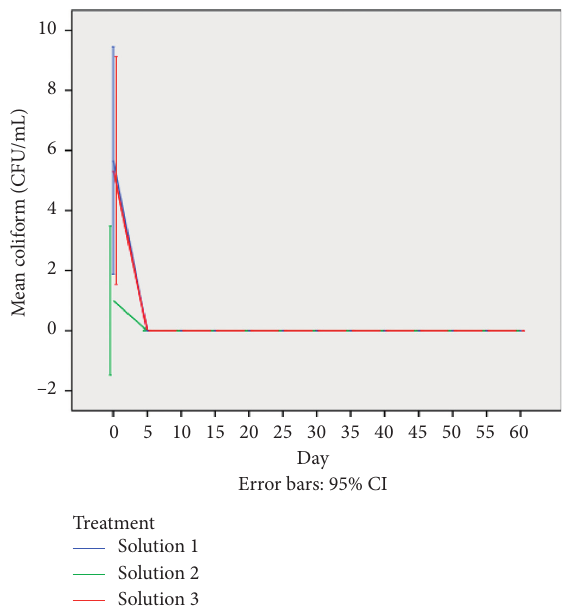
Figure 3: Changes (means ± SD) in Coliform count of antimi- crobial edible coating solutions: solution 1 (0.250 g/L Delvocid), solution 2 (0.275 g/L Delvocid), and solution 3 (0.300g/L Delvocid) during the storage at 8 ° C and 85% RH.